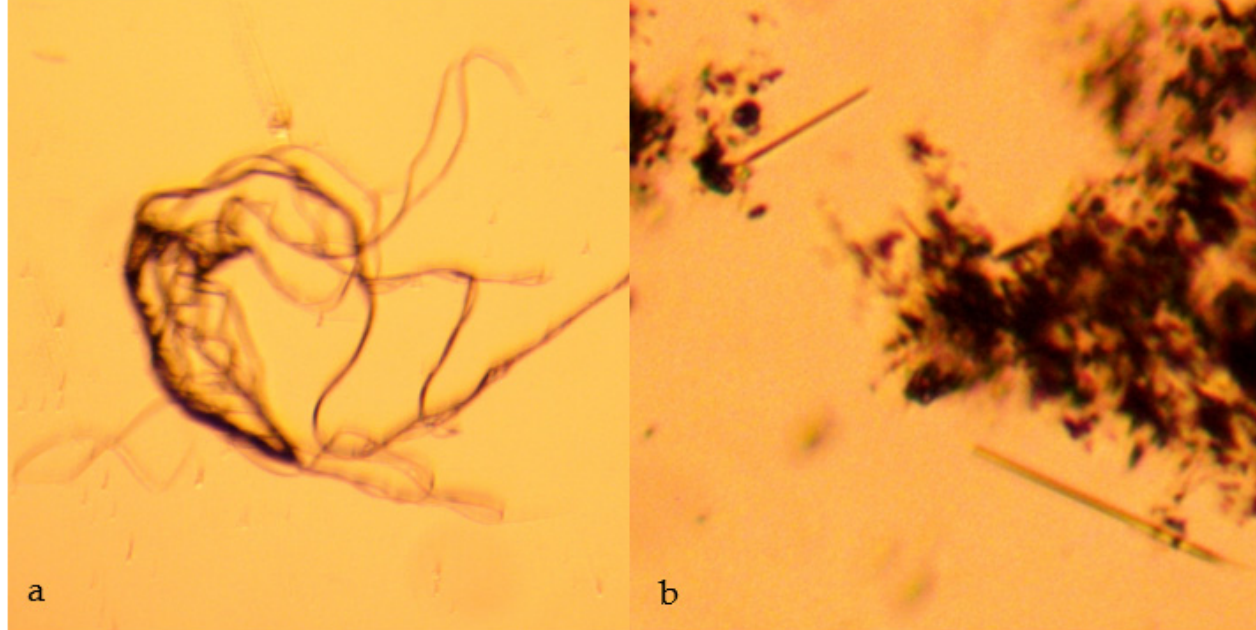
Figure 2. Examples of iron bacteria. ( a ), Complex iron bacteria and colonial filaments with a well- developed iron exoskeleton. Field of view = 0.31 mm; ( b ), Simple rod-like, colonial, filamented, iron bacteria growing in n-Fe 0 . Field of view = 0.168 mm. Iron bacteria species are normally identified using DNA/RNA analyses. The filaments become high-permeability hollow (Fe(OH) 3 /FeOOH) tubes when the bacterium dies.